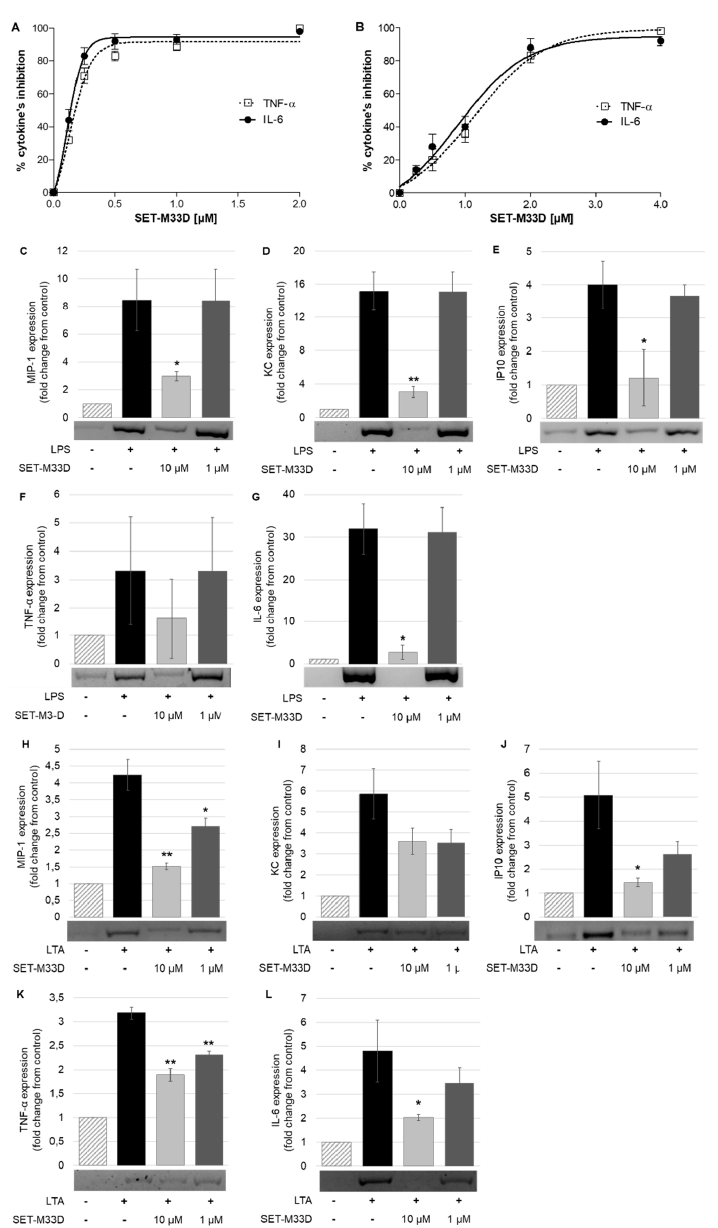
Figure 3. Effect of SET-M33D on protein release or gene expression of proinflammatory cytokines. ( A , B ) ELISA measurement of TNF- α and IL-6 produced by RAW264.7 cells after stimulation with LPS from P. aeruginosa (20 ng/mL) or LTA from S. aureus (2 µg/mL) in the presence of different concentration of SET-M33D. Data is expressed as percentage inhibition of cytokines with respect to LPS or LTA values (100%). Values are the mean ± SD of five independent experiments (n = 5). IC50s are reported in the text. ( C – L ) Gene expression of proinflammatory cytokines MIP1, KC, IP10, TNF- α , and IL-6 was analyzed by RT-PCR. RAW264.7 cells were stimulated with LPS from E. coli ( C – G ) or with LTA from S. aureus ( H – L ) in presence of SET-M33D at 10 or 1 µM. Densitometric analysis of cDNA bands (pictures under the columns) was carried out using ImageJ software. The reduction of cDNA is indicated as fold change with respect to control ± SD of two independent experiments (n = 2). * p < 0.05, ** p < 0.01 calculated using Student’s t -test with GraphPad